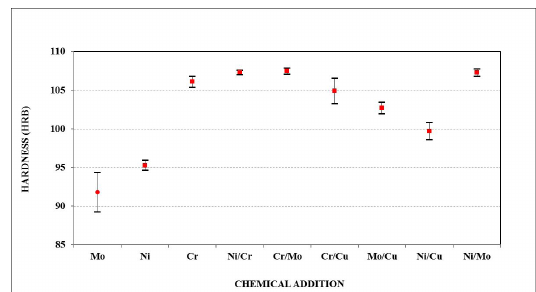
Figure 29. Hardness for each condition.